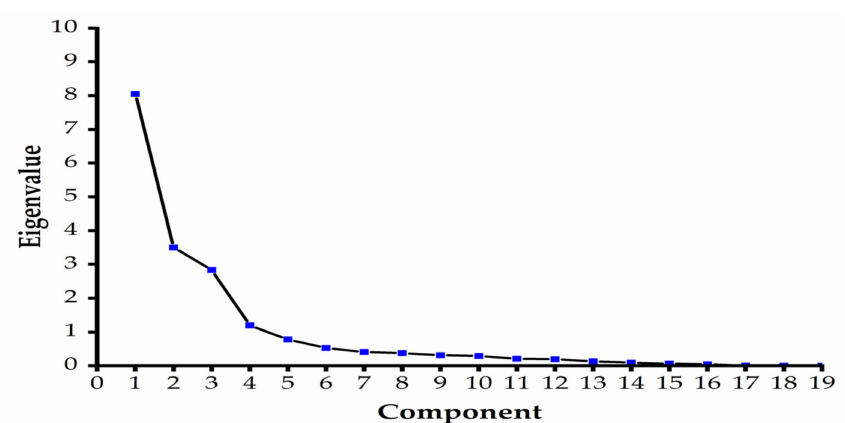
Figure 9. Scree plot of principal component analysis components of quinoa cultivars subjected to foliar application of Azolla (AE) and moringa (MLE) extracts.